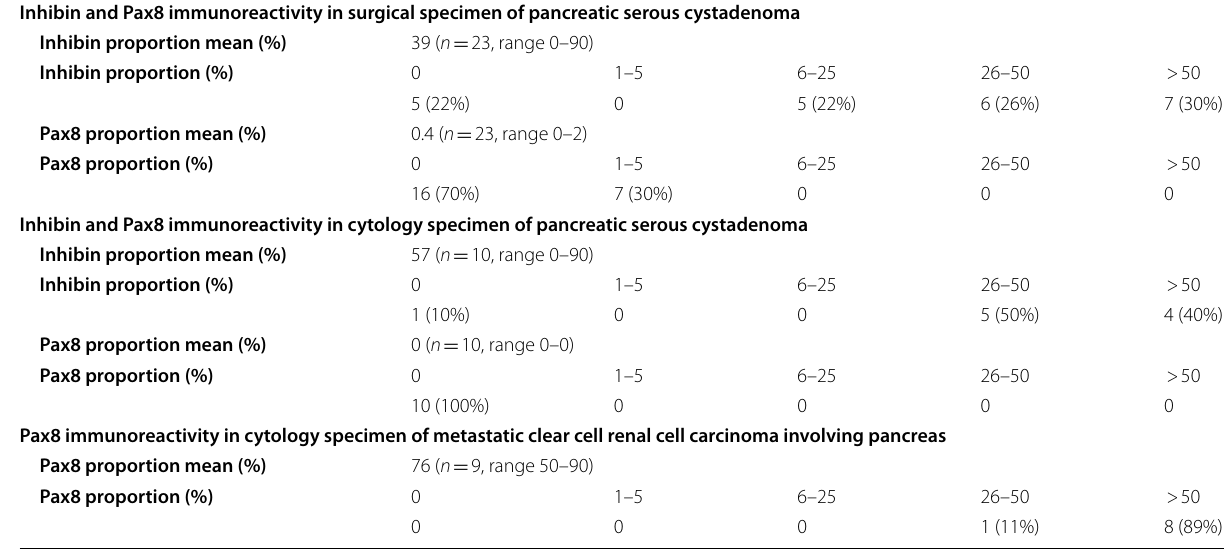
Table 2 Inhibin and Pax8 immunoreactivity in pancreatic serous cystadenoma and metastatic clear cell renal cell carcinoma involving pancreas Inhibin and Pax8 immunoreactivity in surgical specimen of pancreatic serous cystadenoma